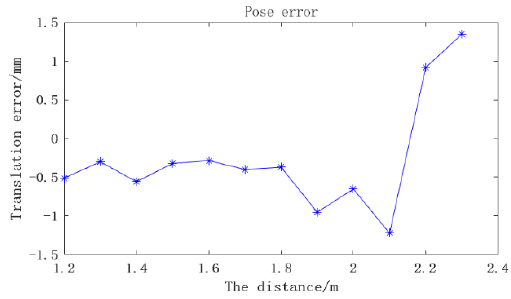
Figure 14. Translation errors at different distances.